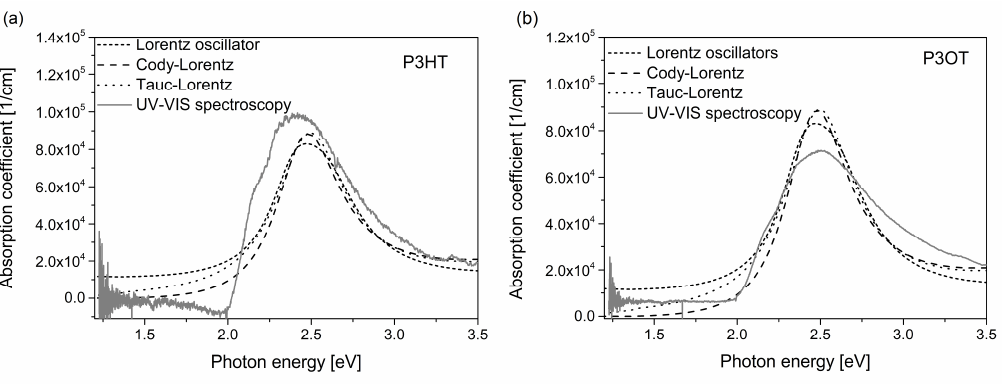
Figure 5. Absolute absorption coefficient determined from spectrophotometry compared with absorption modelled from ellipsometric data ( a ) P3HT, ( b ) P3OT.